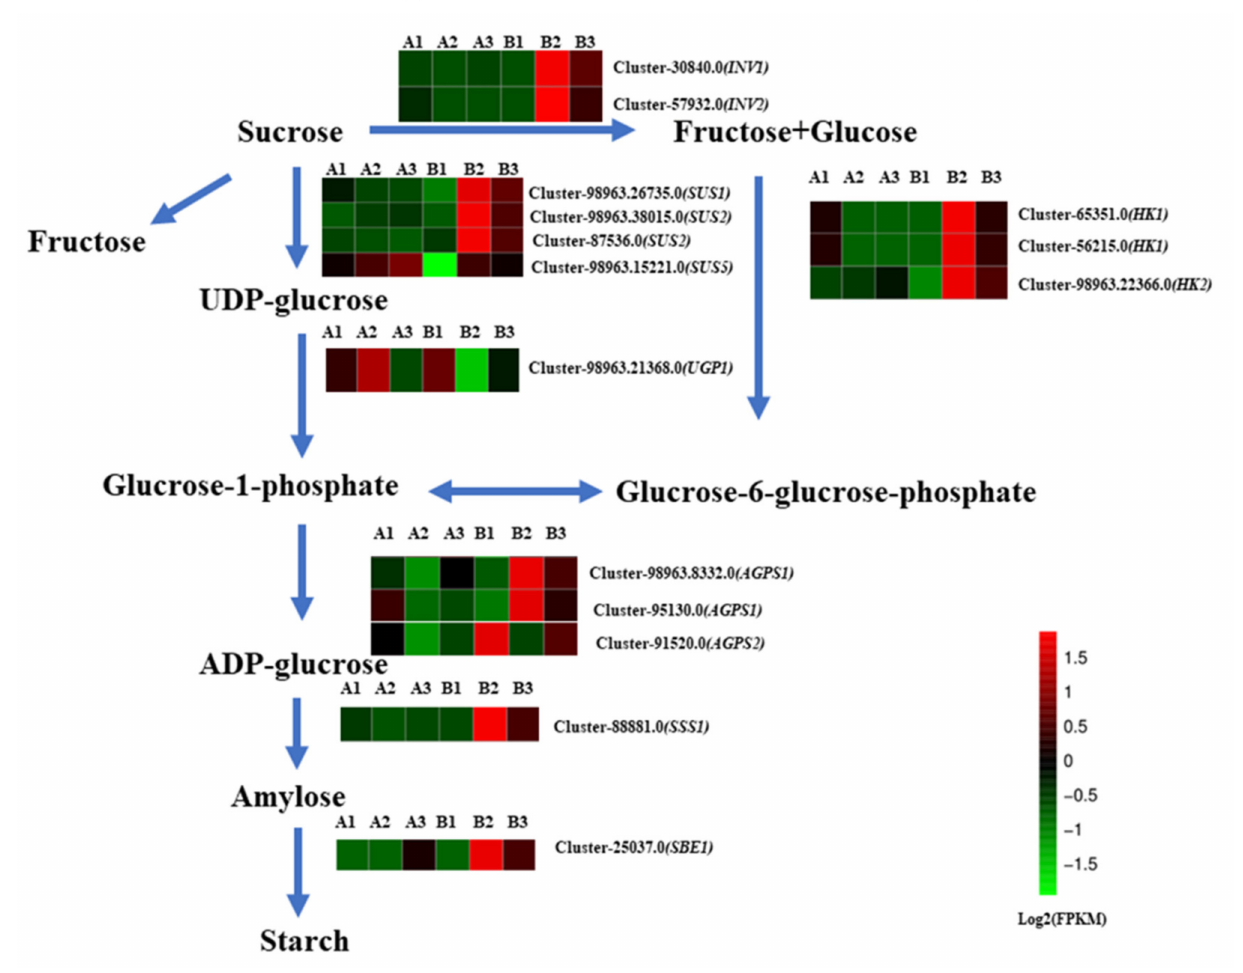
Figure 3. Expression patterns of the expressed genes assigned to starch biosynthesis in oriental lily. A1—vertical (control) group after 20 days of planting; A2—horizontal group after 20 days of planting; A3—slant group after 20 days of planting; B1—vertical (control) group after 50 days of planting; B2—horizontal group after 50 days of planting; B3—slant group after 50 days of planting. The log-transformed expression values range from − 1.5 to 1.5. Red and green colors indicate up- and down- regulated transcripts,